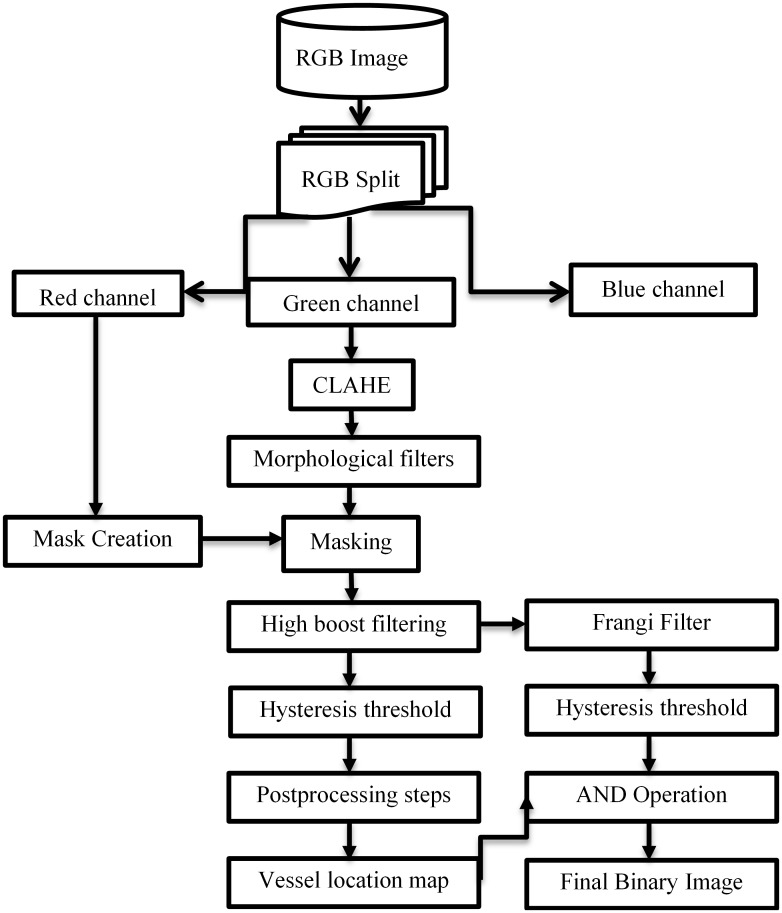
Step-wise illustration of the proposed system.